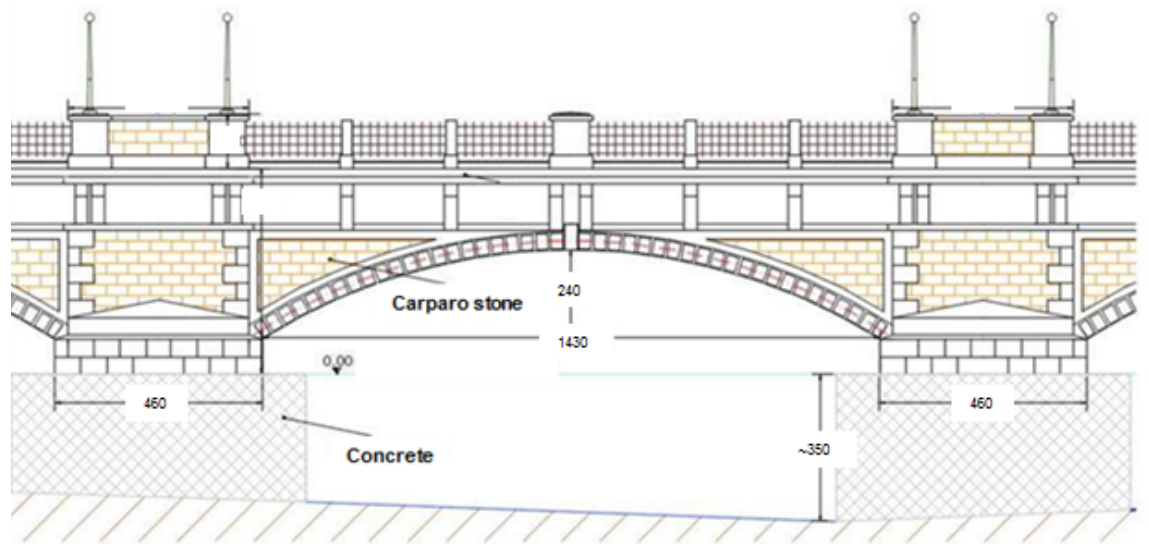
Figure 3: Porta Napoli arch